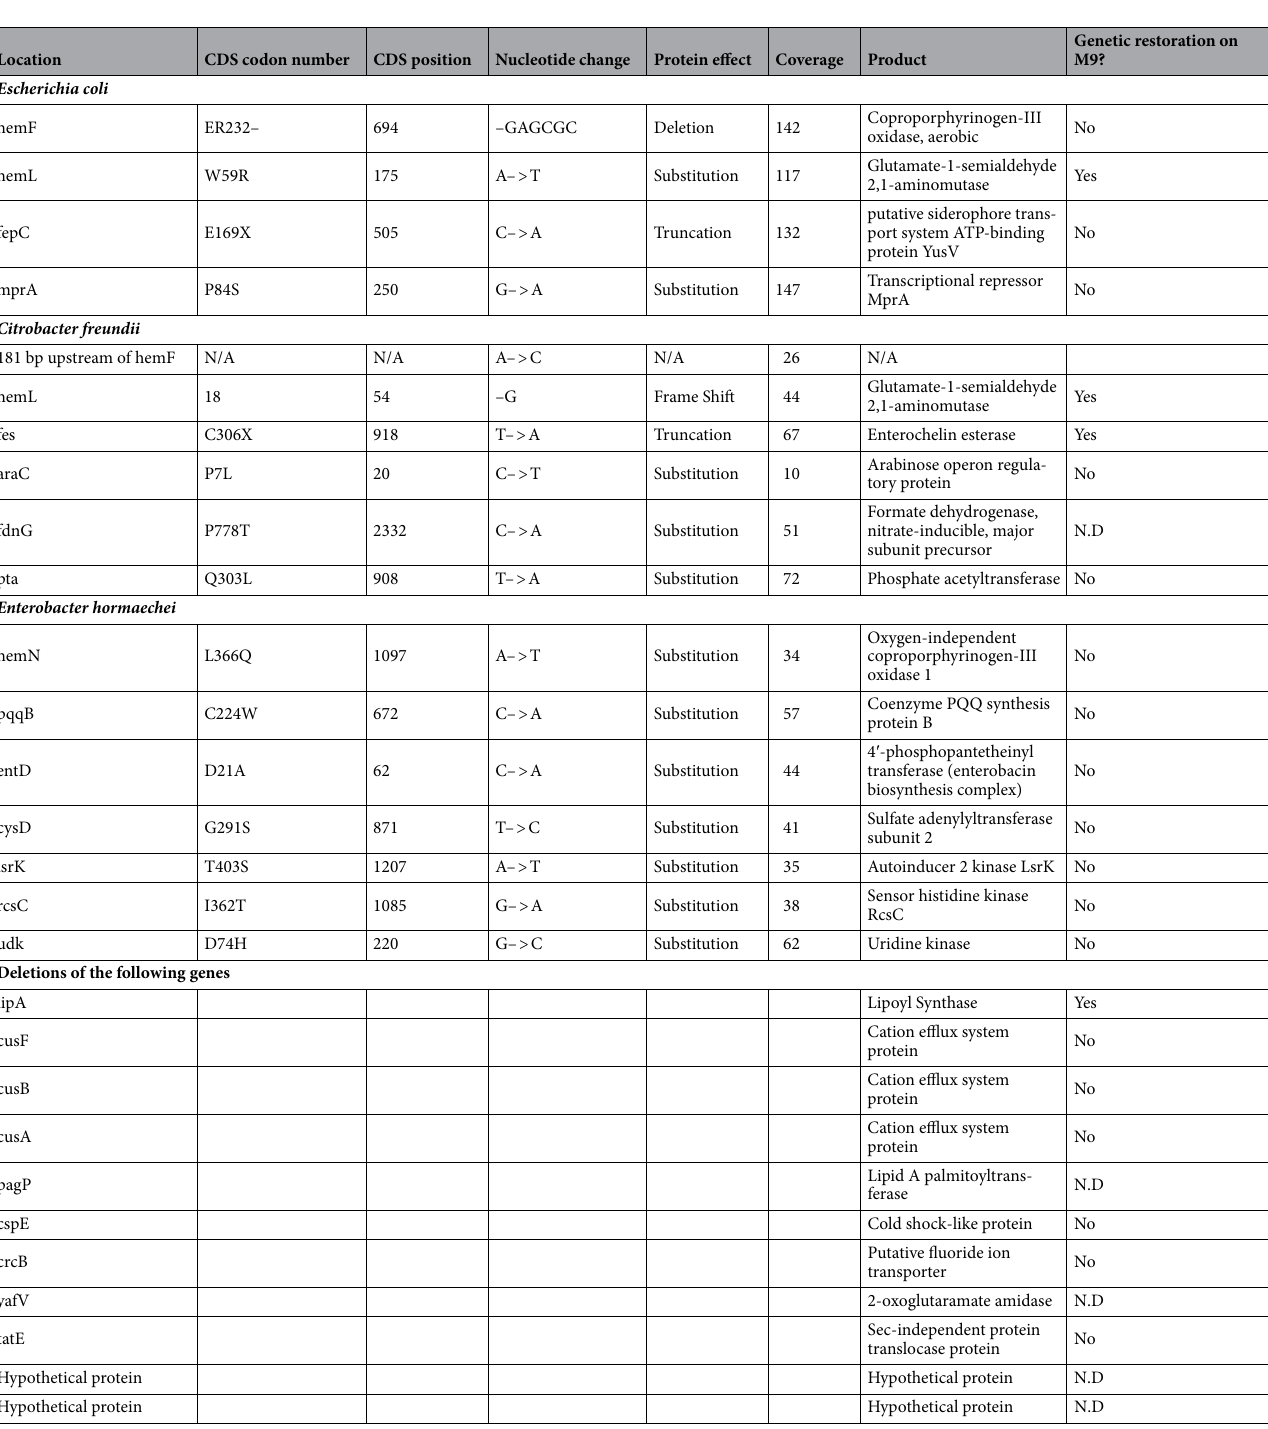
Table 2. Genomic variants isolated from paired clinical co-isolates of Escherichia coli , Citrobacter freundii , Enterobacter hormaechei